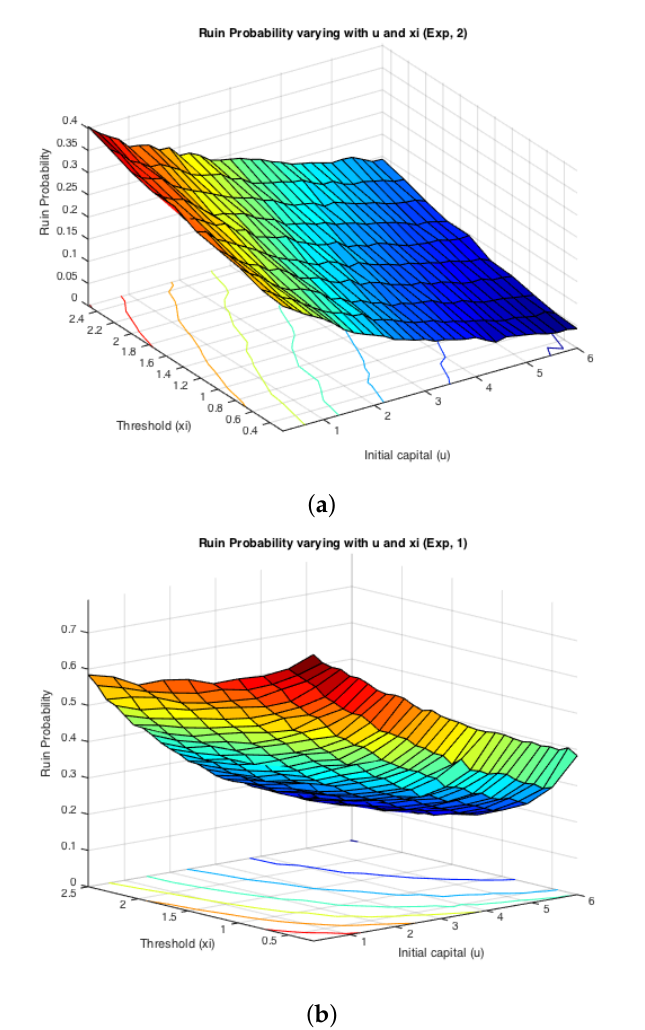
Figure 6. Examples: ruin probabilities for exponential claims. ( a ) Ruin probabilities when λ 1 = 0.45, λ 2 = 0.15, β = 0.5; ( b ) ruin probabilities when λ 1 = 0.15, λ 2 = 0.45, β = 0.5.